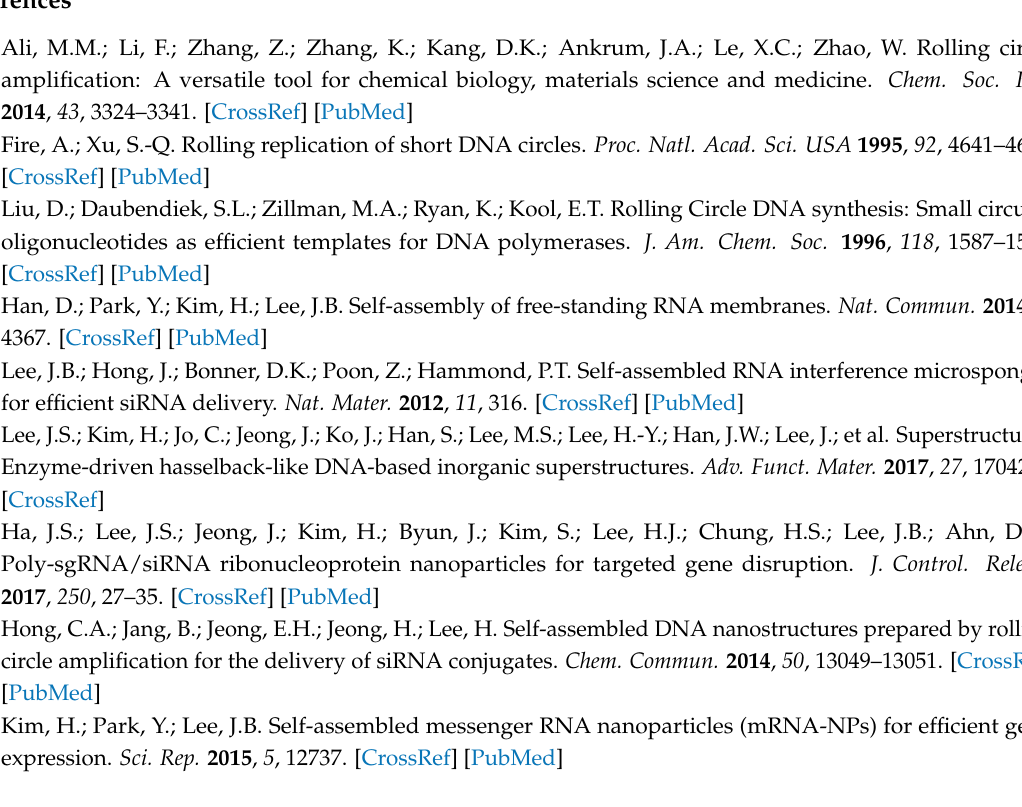
Supplementary Materials: The following are available online, Figure S1: UV absorbance of DNPs at 260 nm, Figure S2: DLS analysis showing hydrodynamic sizes of DNPdTTP produced by RCA at various reaction times, Figure S3: Relative cellular uptake of DNPdTTP into HeLa cells in the presence and absence of endocytosis inhibitors. Chlorpromazine (CPZ) is an inhibitor for the clathrin-dependent endocytosis. Methyl- β -cyclodextrin (MbCD) is an inhibitor for the caveolae-dependent endocytosis. 5-(N-ethyl-N-isopropyl) amiloride (EIPA) is an inhibitor for macropinocytosis. Poly-inosinic acid (poly-I) is an inhibitor for scavenger receptor-mediated endocytosis. The uptake levels were measured by flow cytometry. The data show the results of triplicated